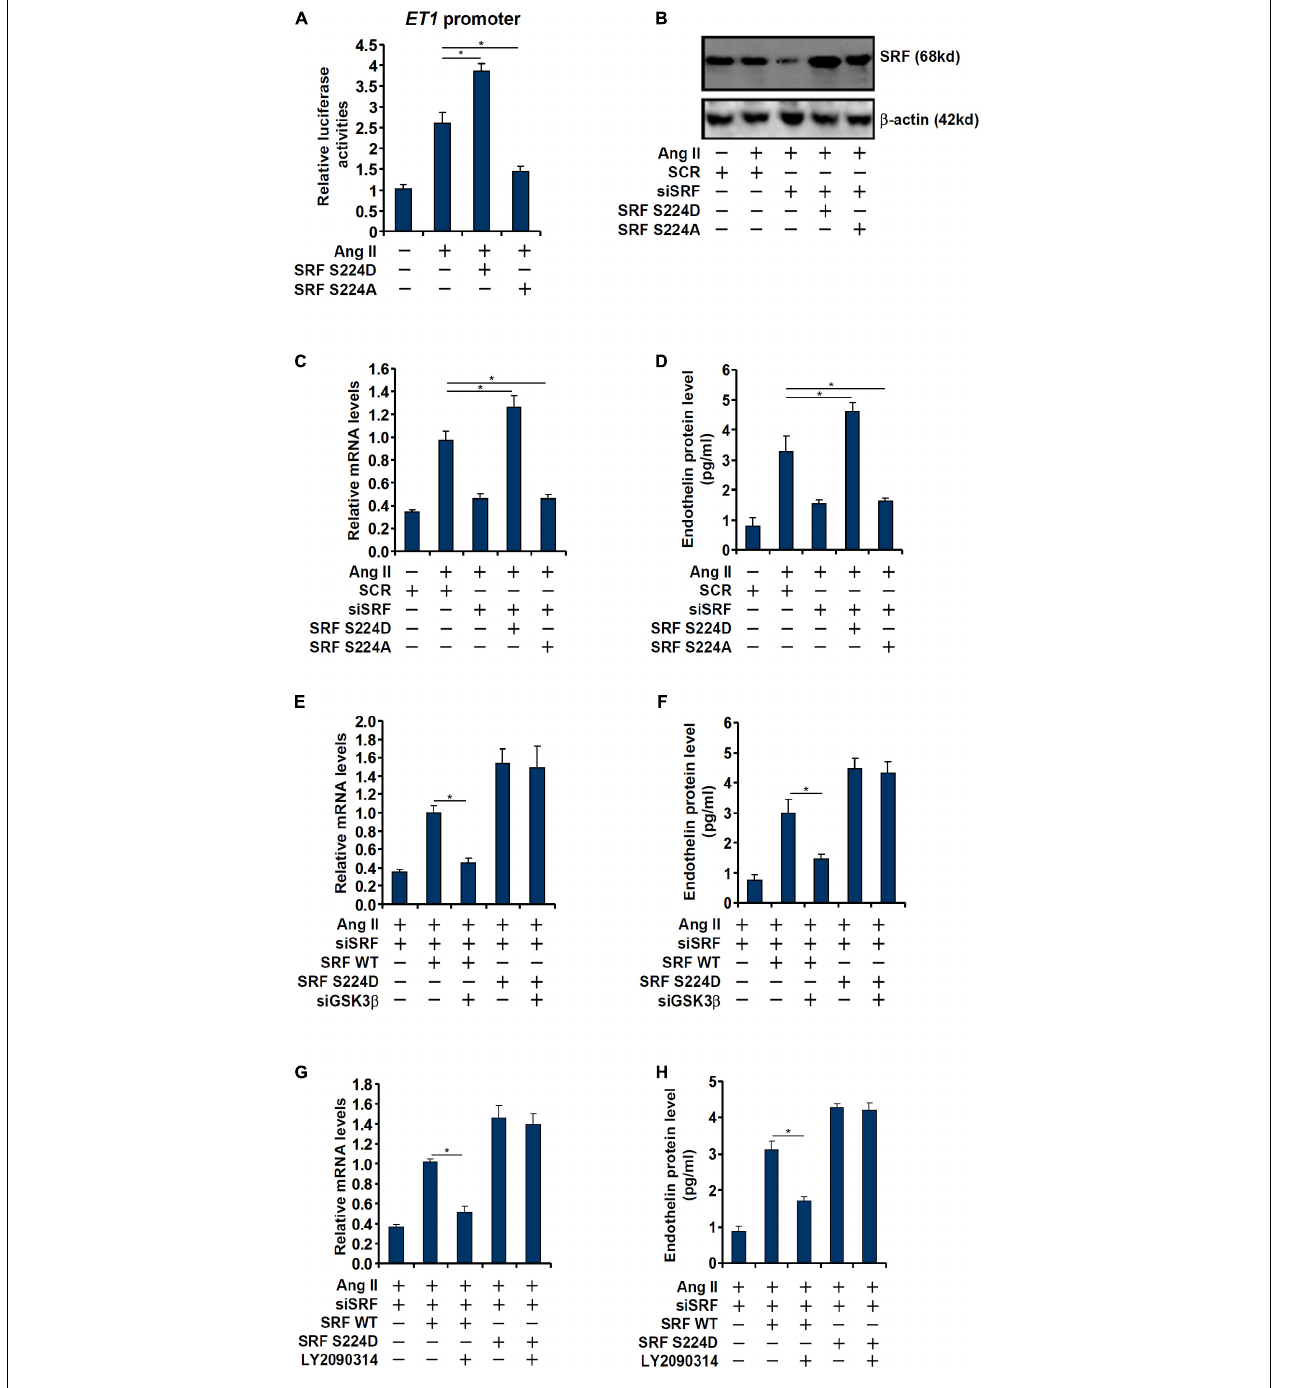
FIGURE 4 | Phosphorylation of SRF by GSK3 is essential for Ang II induced endothelin expression. (A) An ET1 promoter-luciferase construct was transfected into EAhy926 cells with indicated SRF expression constructs (S224A or S224D) followed by treatment with Ang II (0.1 µ M) for 48 h. Luciferase activities were normalized by protein concentration and GFP fluorescence. (B–D) EAhy926 cells were transfected with siRNA targeting SRF followed by transduction with adenoviral SRF expression constructs (S224A or S224D) and treatment with Ang II (0.1 µ M) for 48 h. SRF expression was examined by Western. Endothelin expression was examined by qPCR and ELISA. (E,F) EAhy926 cells were transfected with siRNA targeting SRF/GSK3 β followed by transduction with adenoviral SRF expression constructs (WT or S224D) and treatment with Ang II (0.1 µ M) for 48 h. Endothelin expression was examined by qPCR and ELISA. (G,H) EAhy926 cells were transfected with siRNA targeting SRF followed by transduction with adenoviral SRF expression constructs (WT or S224D) and treatment with Ang II (0.1 µ M) and LY2090314 for 48 h. Endothelin expression was examined by qPCR and ELISA. Error bars represent SD (* p < 0.05, two-way Student’s t -test). All experiments were repeated three times and one representative experiment is